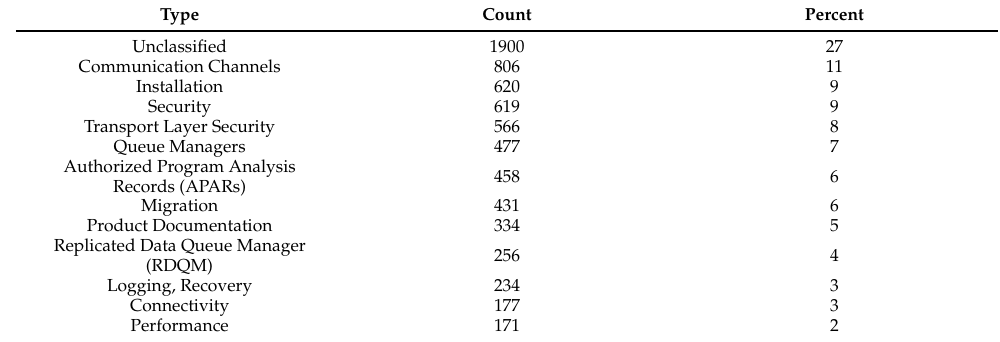
Table 19. Queueing system problems.